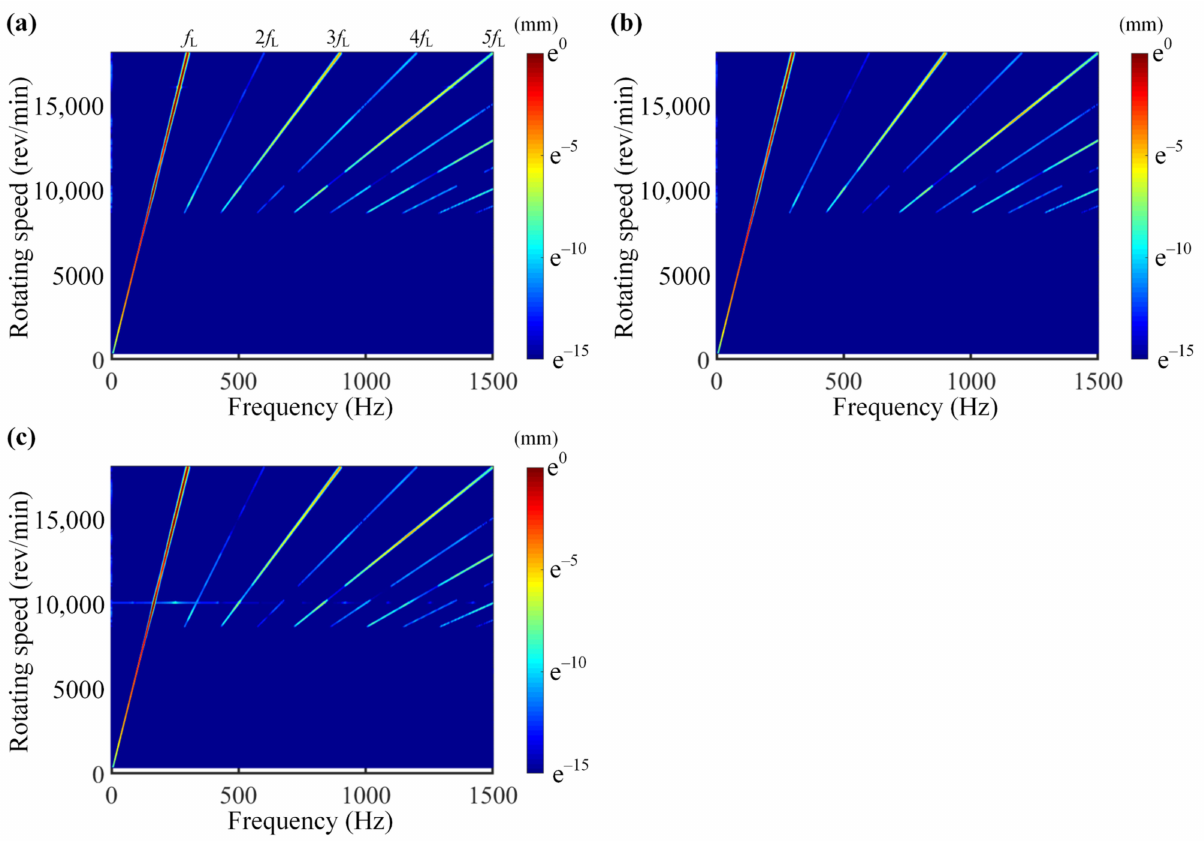
Figure 12. Spectrum cascades of ( a ) prototype and the prediction results from the models ( b ) M1 and ( c ) M2 under LP rotor excitation.